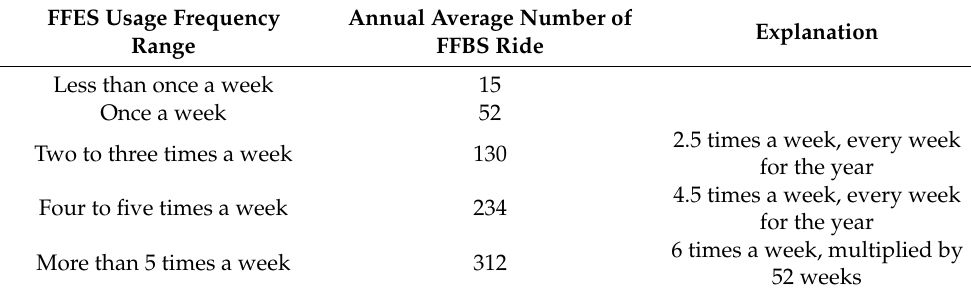
Table 2. Equivalent frequency range and annual average number of FFBS